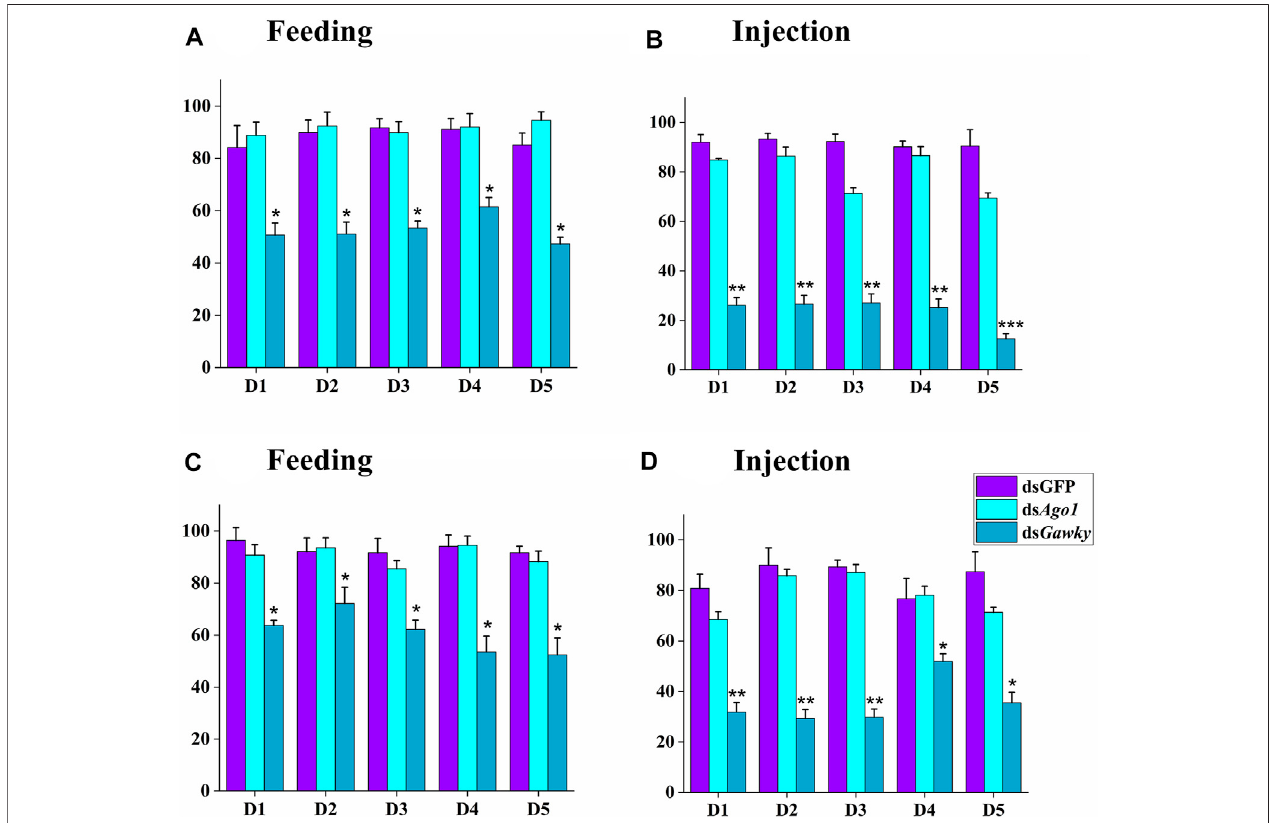
FIGURE6| Effectsof Ago1 and Gawky RNAionegghatchingof Z.cucurbitae .Thelarvaehatchedfromlaideggsin Figure5 wererecordedandthepercentagesof averagenumbersofhatchedeggswerecalculated. (A) and (C) Feedingtreatment. (B) and (D) Injectiontreatment. (A) and (B) Inthecontrolgroup,onedsGFPmalewas crossedwithtwoWTfemales,whileinthetreatmentgroup,onetreatedmalewascrossedwithtwoWTfemales. (C) and (D) Inthecontrolgroup,onedsGFPfemalewas crossed with two WT males, while in the treatment group, one treated female was crossed with two WT males. Statistical signi fi cance was calculated using a one- way ANOVA followed by Tukey ’ s post hoc test. The bars represent the mean ± SD with three biological replicates. The asterisks above the bars represent signi fi cant differences between the control and treatment groups (* p < 0.05; ** p < 0.01; *** p ≤ 0.001).